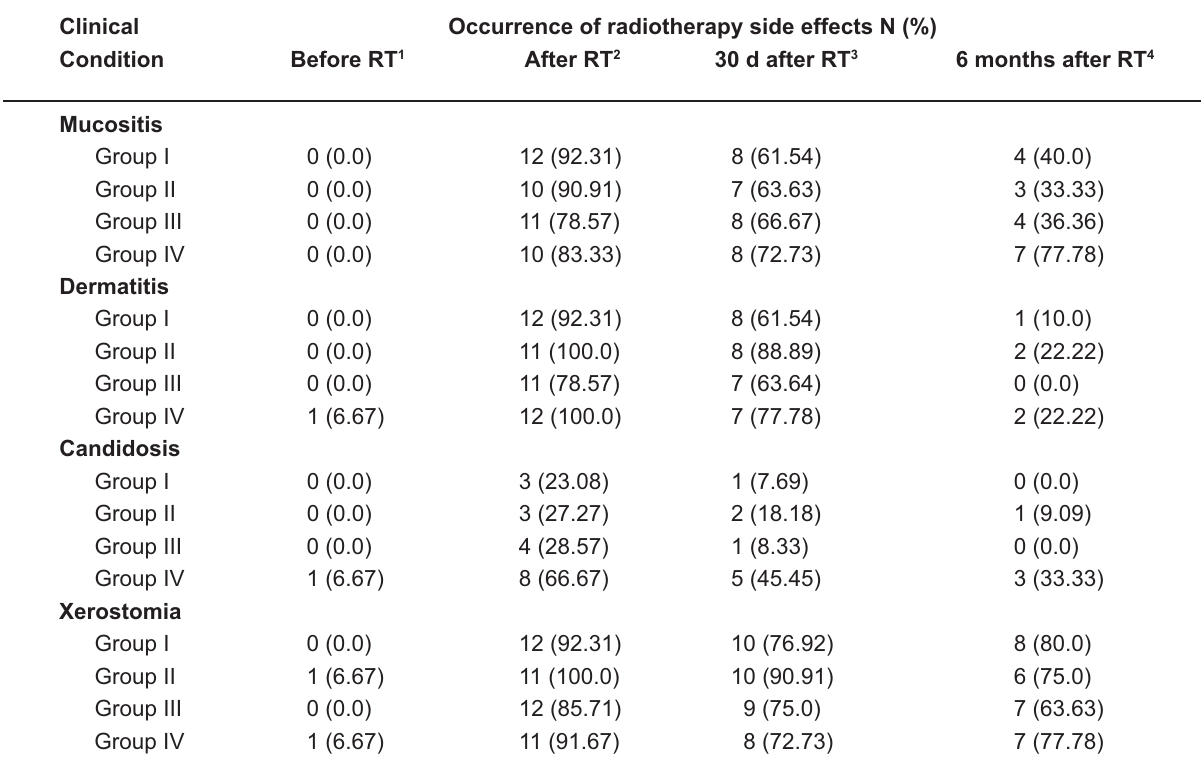
1 Number of patients in the different groups just before radiotherapy: Group I, N= 15; Group II, N= 15; Group III, N= 15; Group IV, N= 15. Total =